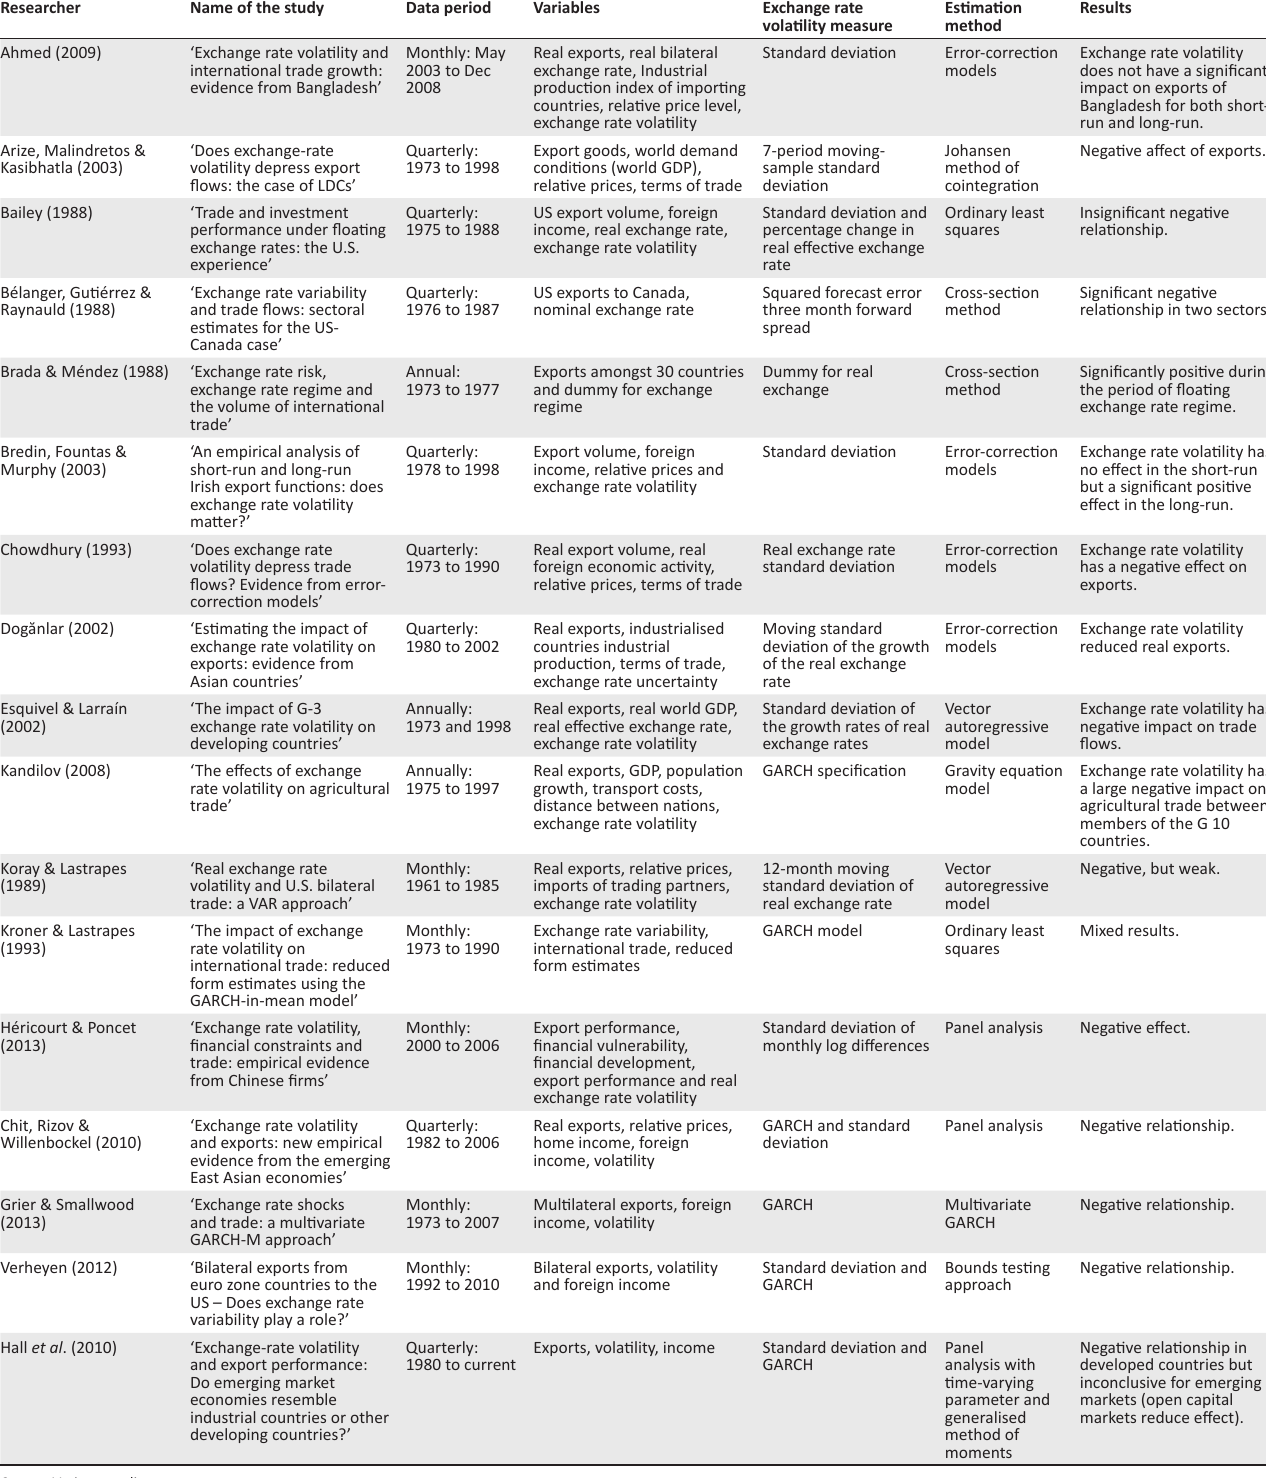
TABLE 1-A1 : Summary of selected studies on the impact of exchange rate volatility.